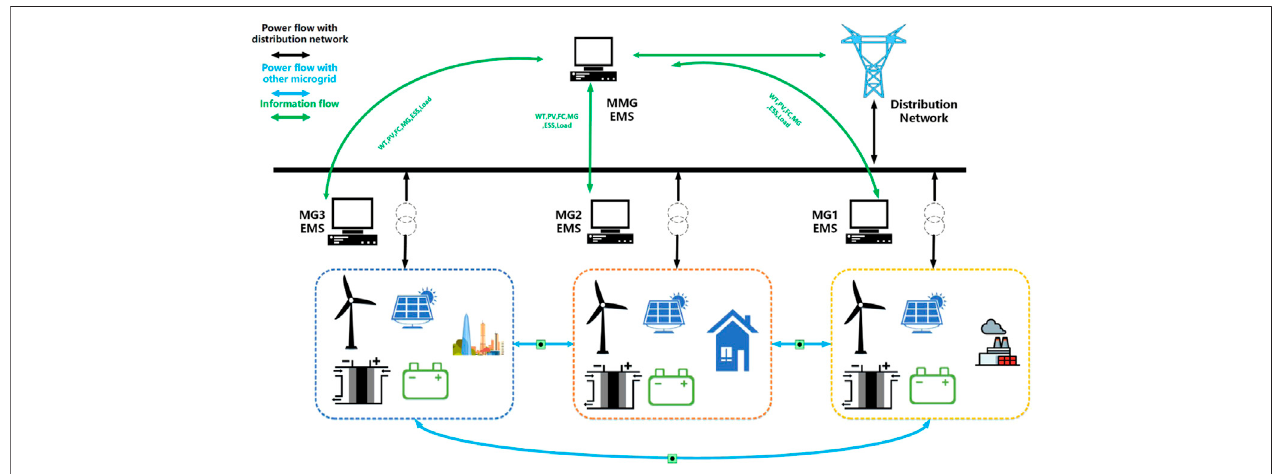
FIGURE 1 | Topology of the